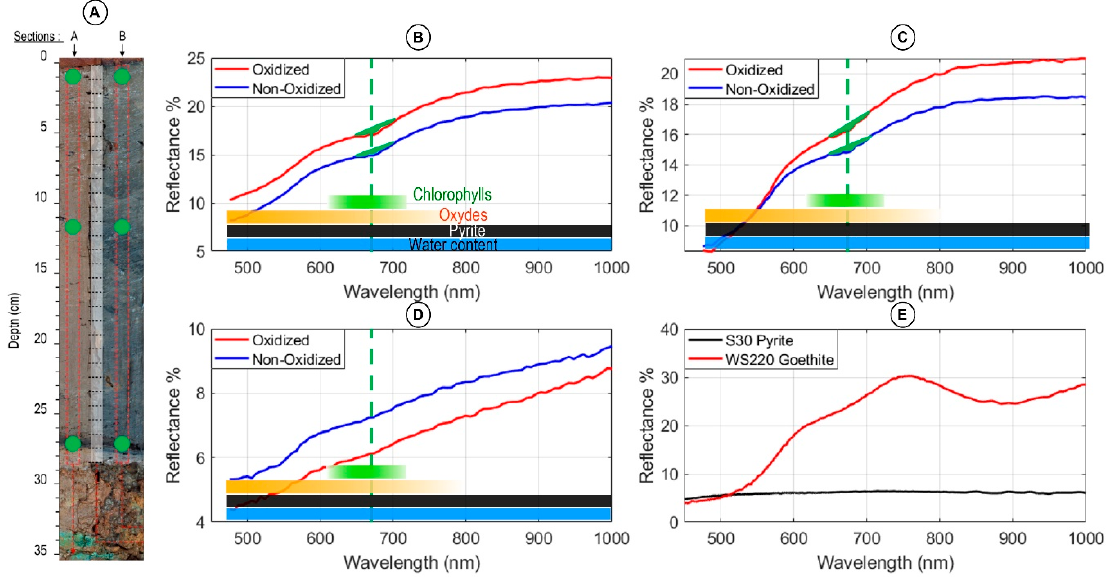
Figure 4. ( A ) Sediment Core BRE16-01 ( B – D ) Presentation of spectra in three representative areas of the chlorophyll- a and pigments contents according to the oxidized (red spectra) or non-oxidized (blue spectra) section. The local minimum of the chlorophyll- a at 675 nm is represented with the dotted green line, and its spectral area is colored in green. ( E ) Reflectance of pure standard samples of pyrite and goethite [60] are presented to describe the reflectance of reduced iron (Fe-S, pyrite) and oxidized iron (Fe-O, goethite). The higher reflectance of goethite at long wavelengths explains the difference in reflectance between sections ( A , B ). The wavelengths impacted both by chlorophyll- a and by the sedimentary components related to the oxidation of sediment are shown. Sediment oxidation produces a smaller increase in reflectance at short wavelengths due to the formation of iron oxides.